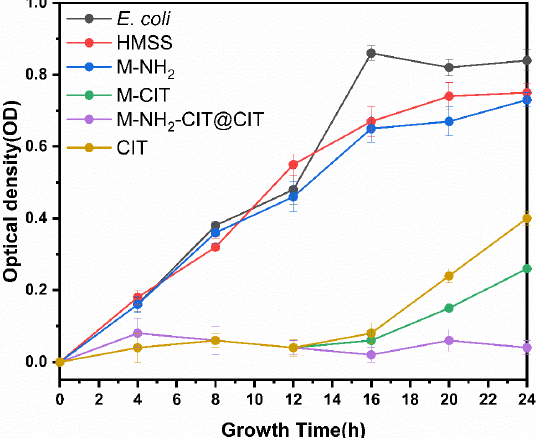
Figure 8 . OD growth curves of E. coli in TSB in the presence of different samples: HMSS, M-NH 2 , M-CIT, M-NH 2 -CIT@CIT, and CIT.